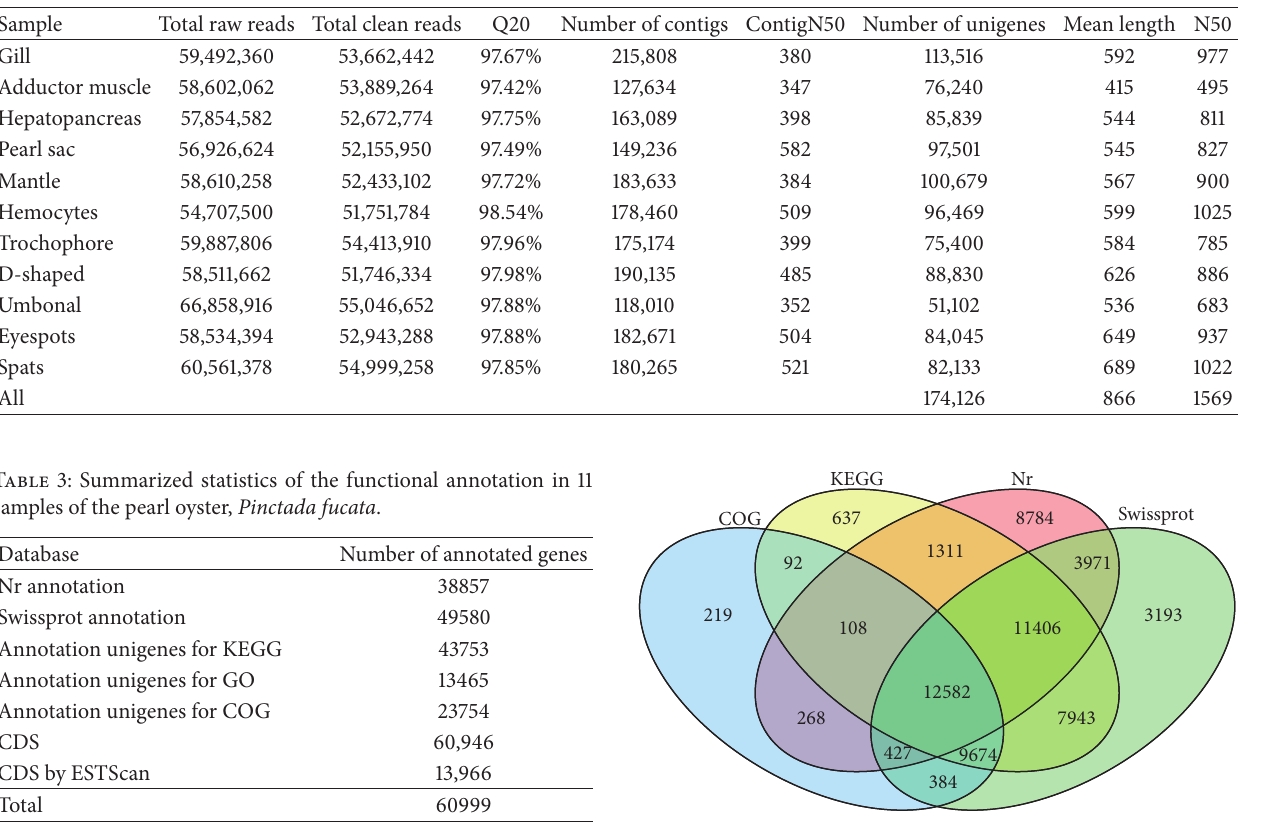
Figure 2: Number of genes annotated by COG, KEGG, Nr, and Swissprottermsbasedonfivelarvalstagesandsixtissuesof Pinctada fucata